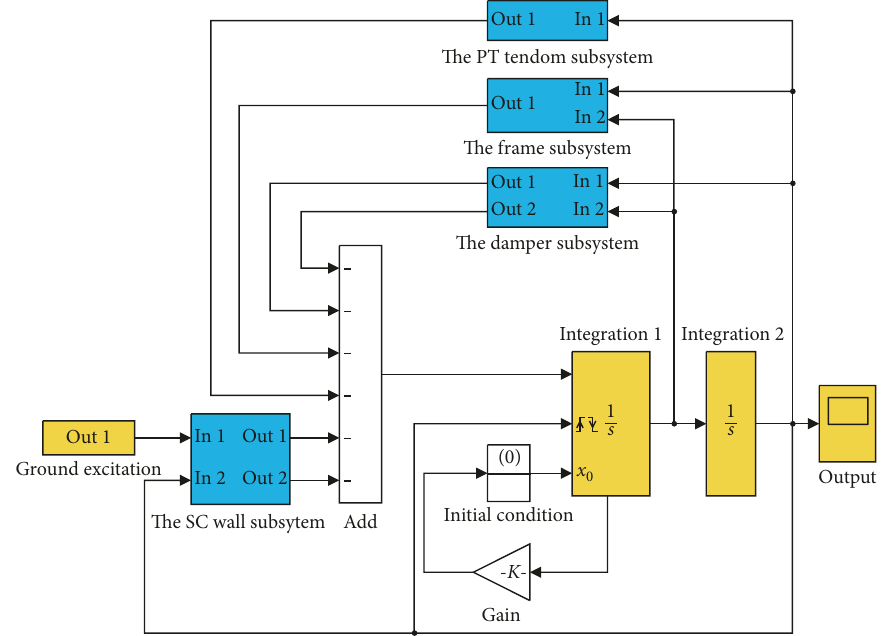
Figure 15: Simulink model of the FSCW structure.